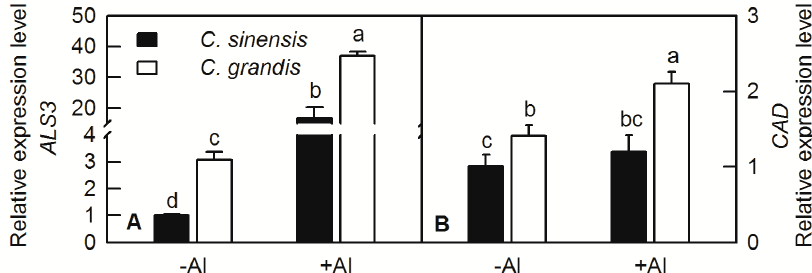
Figure 4. Relative expression levels of ALS3 ( A ) and CAD ( B ) in C. grandis and C. sinensis under Al treatment. Bars represent means ± SD ( n = 4). Di ff erent letters above the bars indicate a significant di ff erence at p <